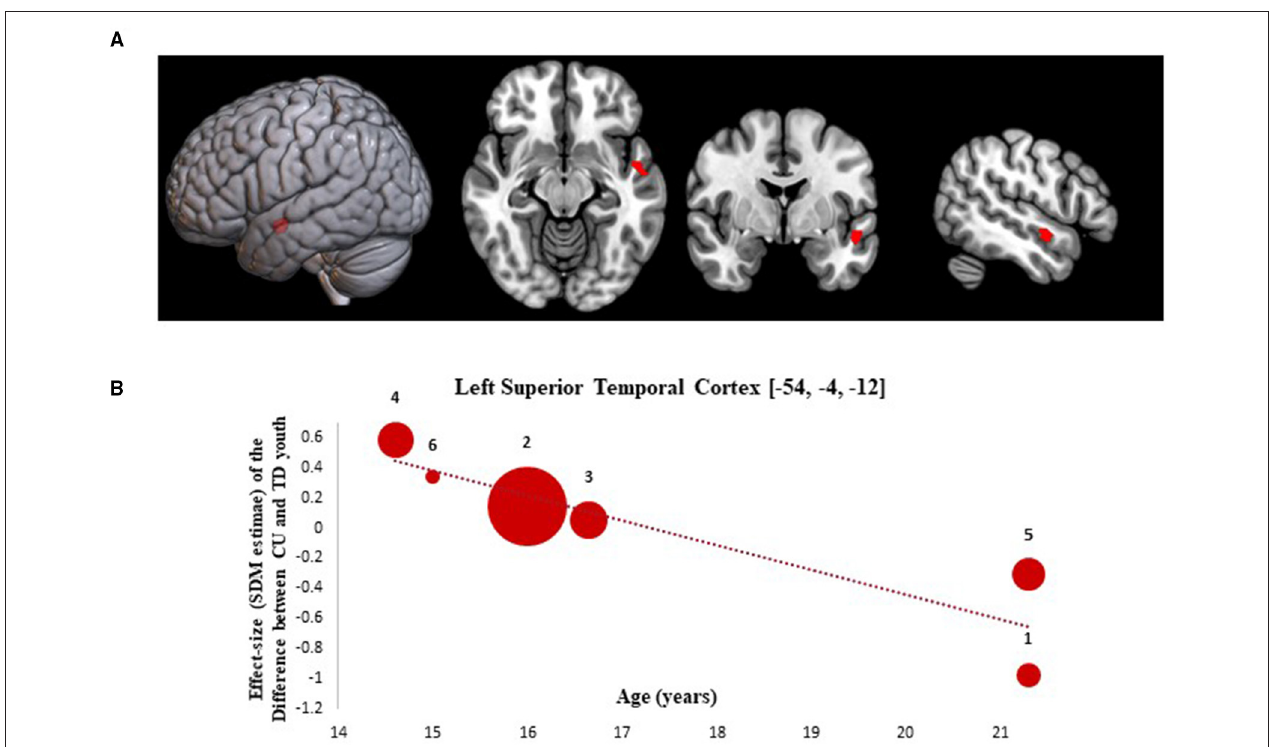
FIGURE 2 | Meta-regression results showing associations between age at scan with gray matter differences between cannabis using and typically developing youth. Age-related meta-regression results. (A) Meta-regression results (CU > TD youth) showing associations between Age at Scan and gray matter differences between CU and TD youth shown in red. All results thresholded at p < 0.005. (B) Associations between age and gray matter differences in the left superior temporal cortex (85 voxels, SDM-Z = − 3.168) (shown in red). Effect sizes (SDM-estimates) used to create the meta-regression plots were extracted from the peak of maximum slope significance. The meta-regression SDM-estimate value is derived from the proportion of studies that reported gray matter changes near the voxel so it is expected that some values are at 0 or near + /– 1. Each included study is represented as a numbered dot, with the dot size reflecting relative total sample size of each specific study in comparison to the average total sample size of all six studies included in the regression. Study key: 1 = Gilman et al. ( 39); 2 = Thayer et al. (41); 3 = Weiland et al. ( 11); 4 = Orr et al. (12); 5 = Cousijn et al. (40); 6 = Jarvis et al.